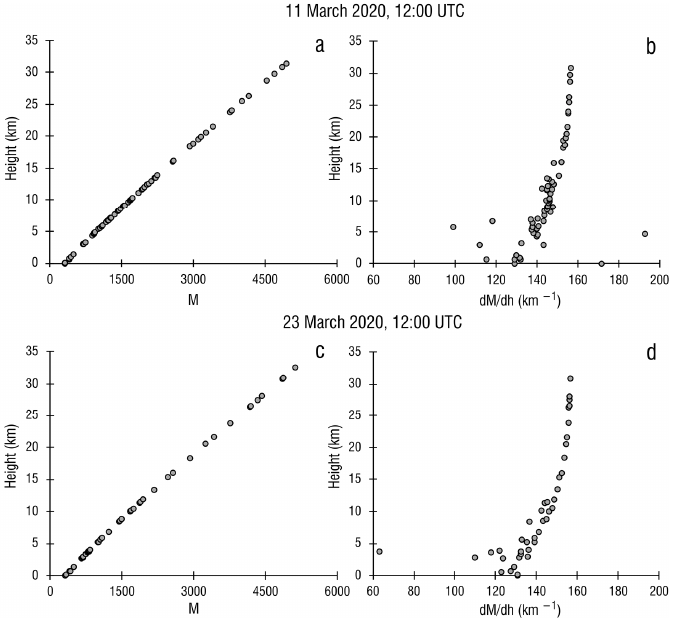
Figure 3. Tropospheric refractive conditions during aerological probing over Zagreb, Croatia, nearest in time to the acquisition of the Sentinel-1B pair of images: ( a ) vertical profile of the modified refraction index on 11 March 2020, 12:00 UTC; ( b ) vertical profile of the modified refraction index gradient on 11 March 2020, 12:00 UTC; ( c ) vertical profile of the modified refraction index on 23 March 2020 at 12:00 UTC; ( d ) vertical profile of the modified refraction index gradient on 23 March 2020, 12:00